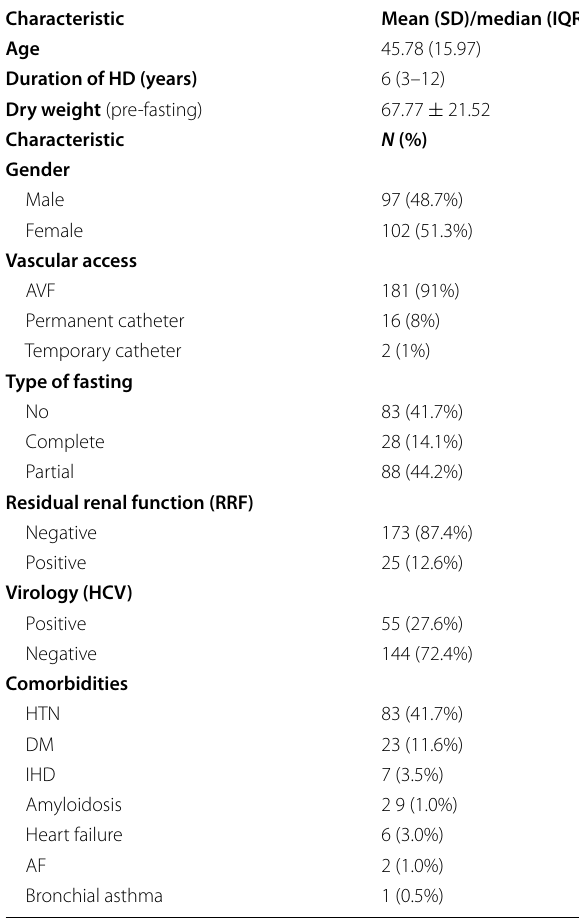
Table 1 Basic demographic data and clinical characteristics of study population